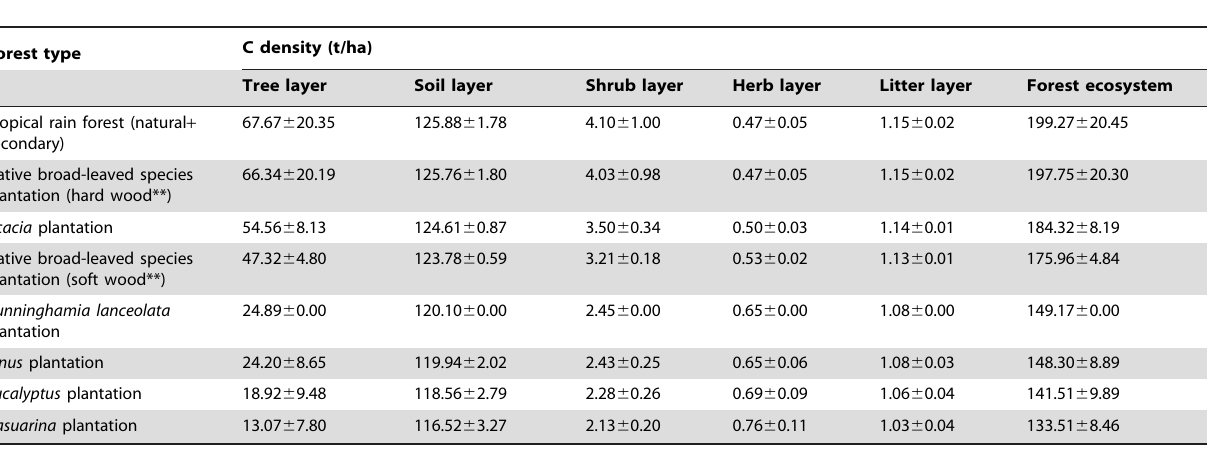
Table 3. Estimations of carbon density in different layers of major forest ecosystems in 2008 with uncertainty analysis (Mean 6 SE).